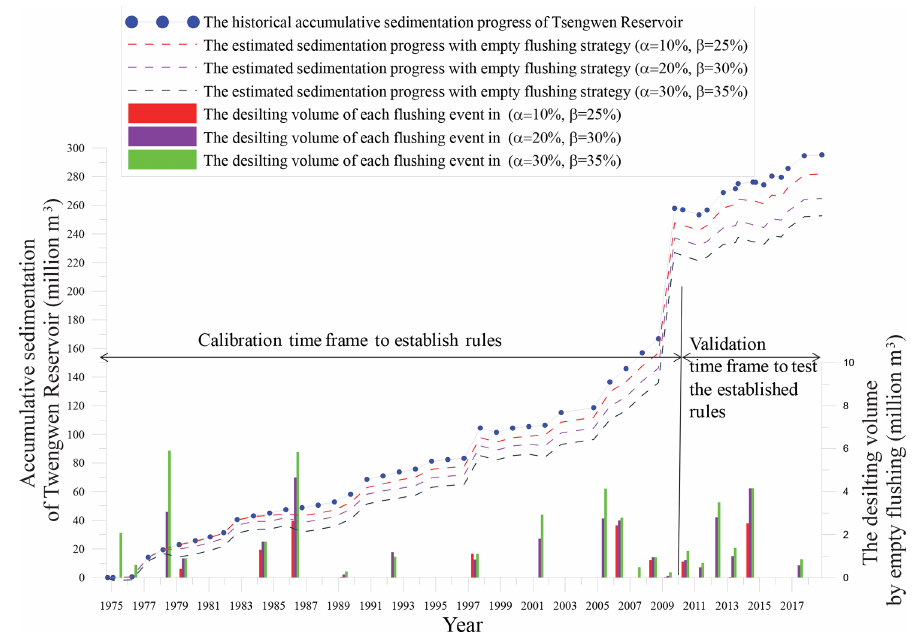
Figure 10. The sedimentation progress of Tsengwen Reservoir with and without empty